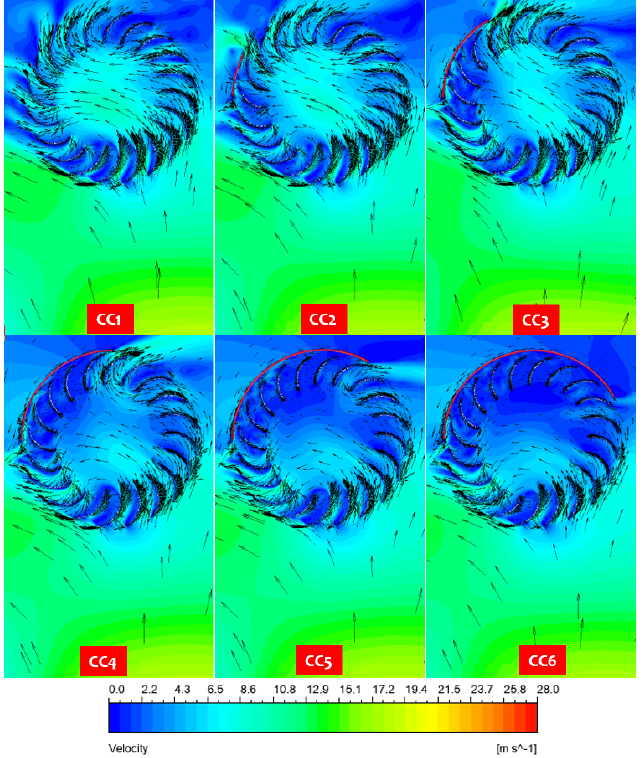
Figure 20. Velocity contours and vectors of each car case in the rotor zone taken at (cid:1872) = 3.5 (cid:1871)